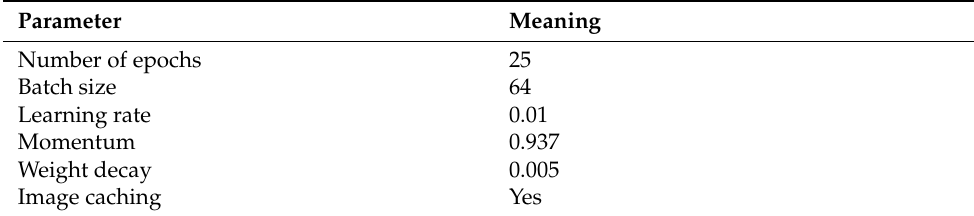
Table 3. Values of YOLOv5 s case hyperparameters during training.